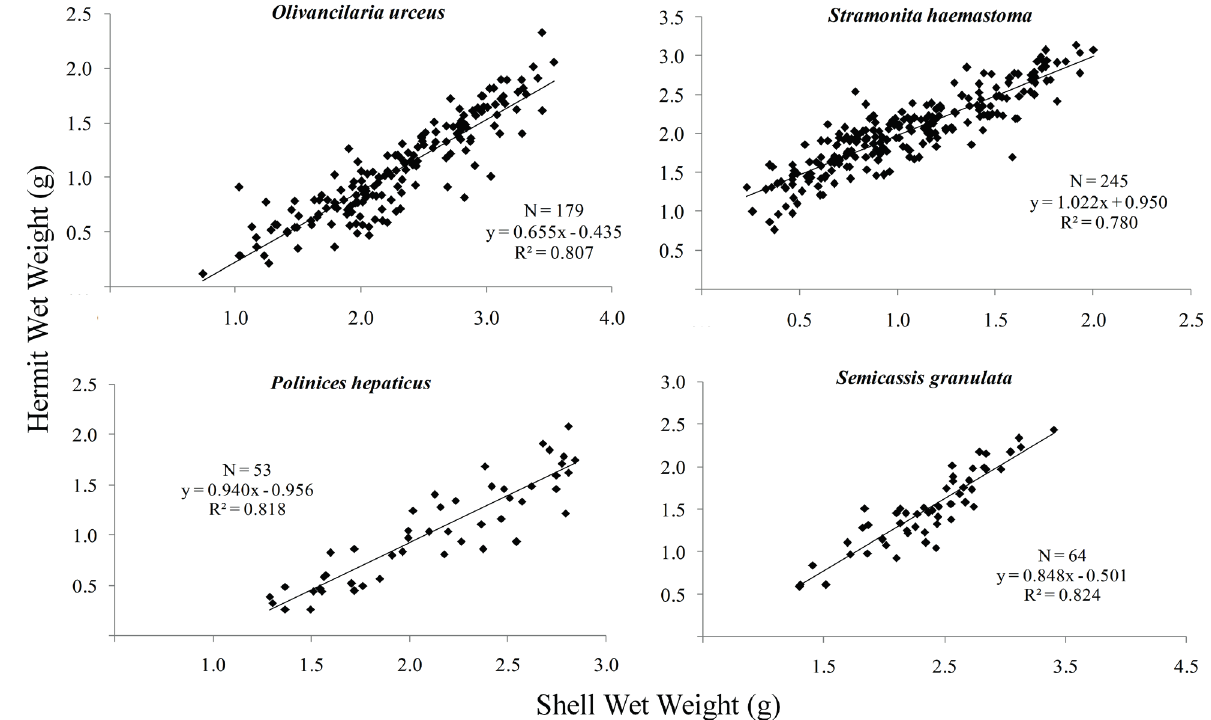
Figure 4. Linear Regression, between Hermit Wet Weight (HWW) vs. Shell Wet Weight (SWW) of gastropod species more occupied by Isocheles sawayai during the study in an area adjacent to Babitonga Bay, Santa Catarina, Brazil. Table 2. Overview in the shell occupation by interest group: females (F), ovigerous females (OF) and males (M) of the